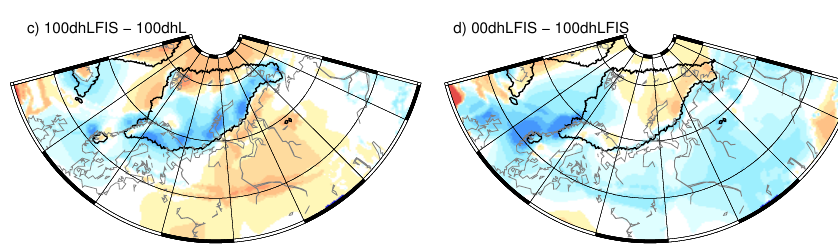
(Fig. 3), when the LIS is flat, the ablation is weaker over the entire SBK region, and increases as the LIS gets higher. Nev- ertheless, even with the full-LGM LIS, the ablation remains weaker than in the noIS